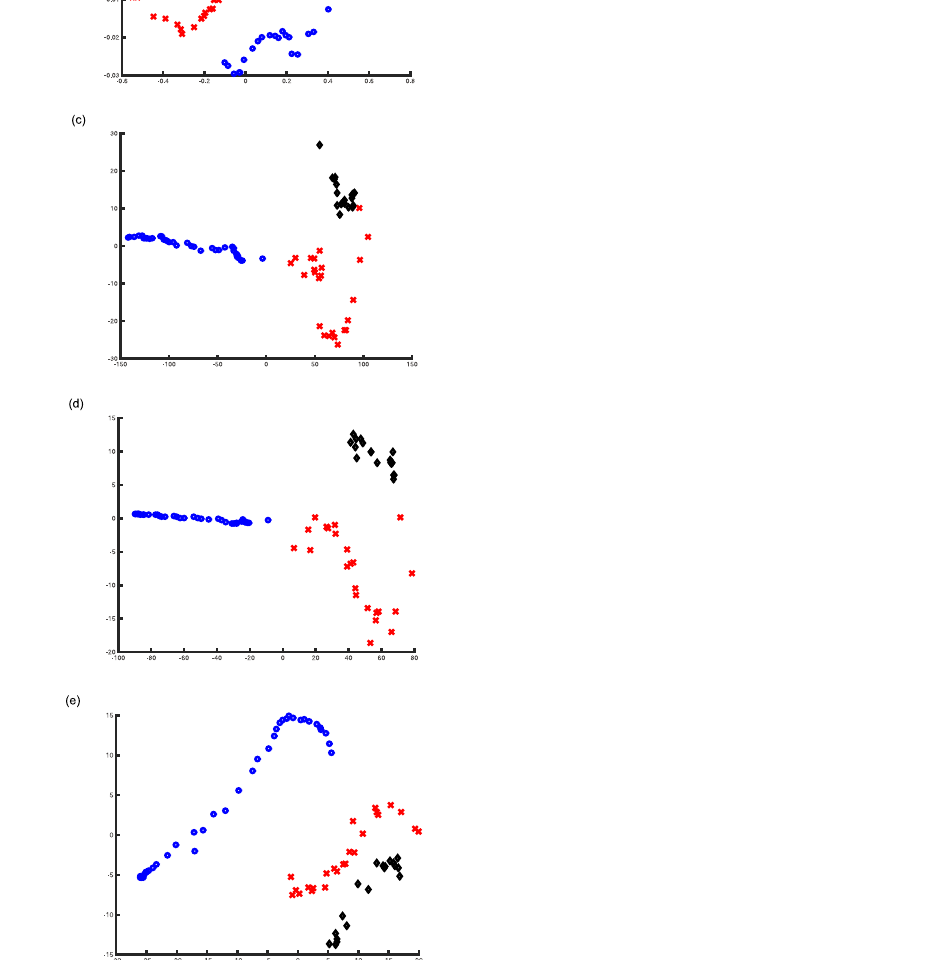
Fig 14. Visualizations of the UMist faces dataset. Different people ’ s faces denote different marks (black rhomb, red cross, blue circle). (a) ITRN-ERBF, (b) ITRN-TRBF, (c) ISOMAP, (d) L-ISOMAP and (e) PCA.